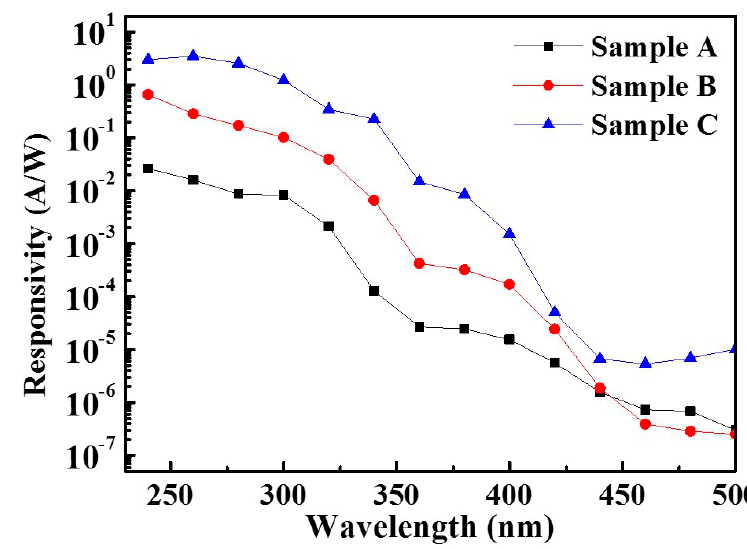
Figure 7. Photoresponsivity of MgInO thin film transistors (TFTs) measured at V DS = 10 V with a wavelength range of 240–500 nm.